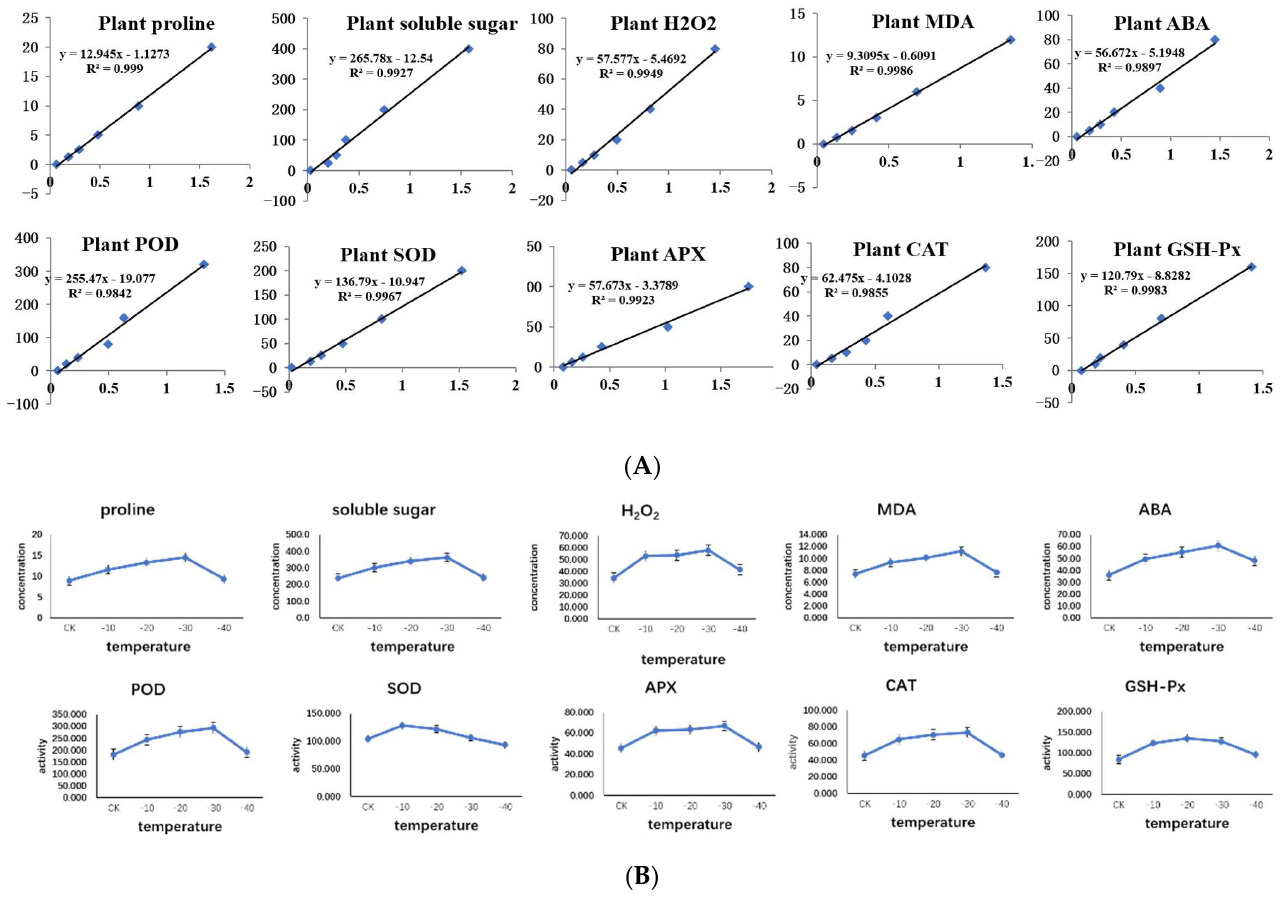
Figure 1. The expression of physiological indicators of A. pseudosieboldianum under freezing stress at different temperatures. ( A ) is the curve analysis of different physiological indicators to determine the accuracy of the test data; ( B ) is the activity and content expression of physiological indicators under freezing stress at different temperatures. These include the enzymatic activities of SOD, POD, CAT, APX and GSH-Px and the accumulation of ABA, MDA, H 2 O 2 , proline, and soluble sugar under freezing stress at different temperatures. Table 1. Summary of the RNA-seq data collected from A. pseudosieboldianum